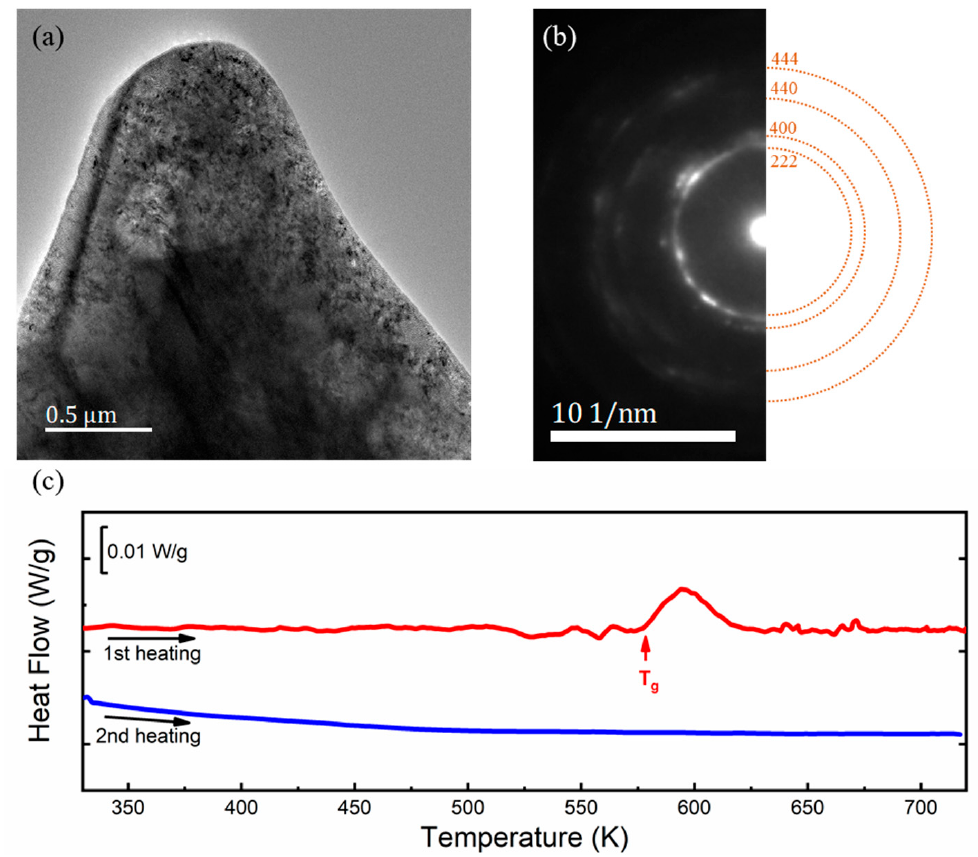
Figure 2. ( a ) TEM bright-field image and ( b ) selected-area diffraction pattern (SADP) reveal an amorphous state of the 90% cold-rolled specimen. The SADP is compared with that of the general FCC Fe 3 Pd crystal. ( c ) The DSC curves exhibit a glass transition from metallic glass to crystal, confirming that the crystallization temperature is around 580 K (the heating rate is 20 K/min).